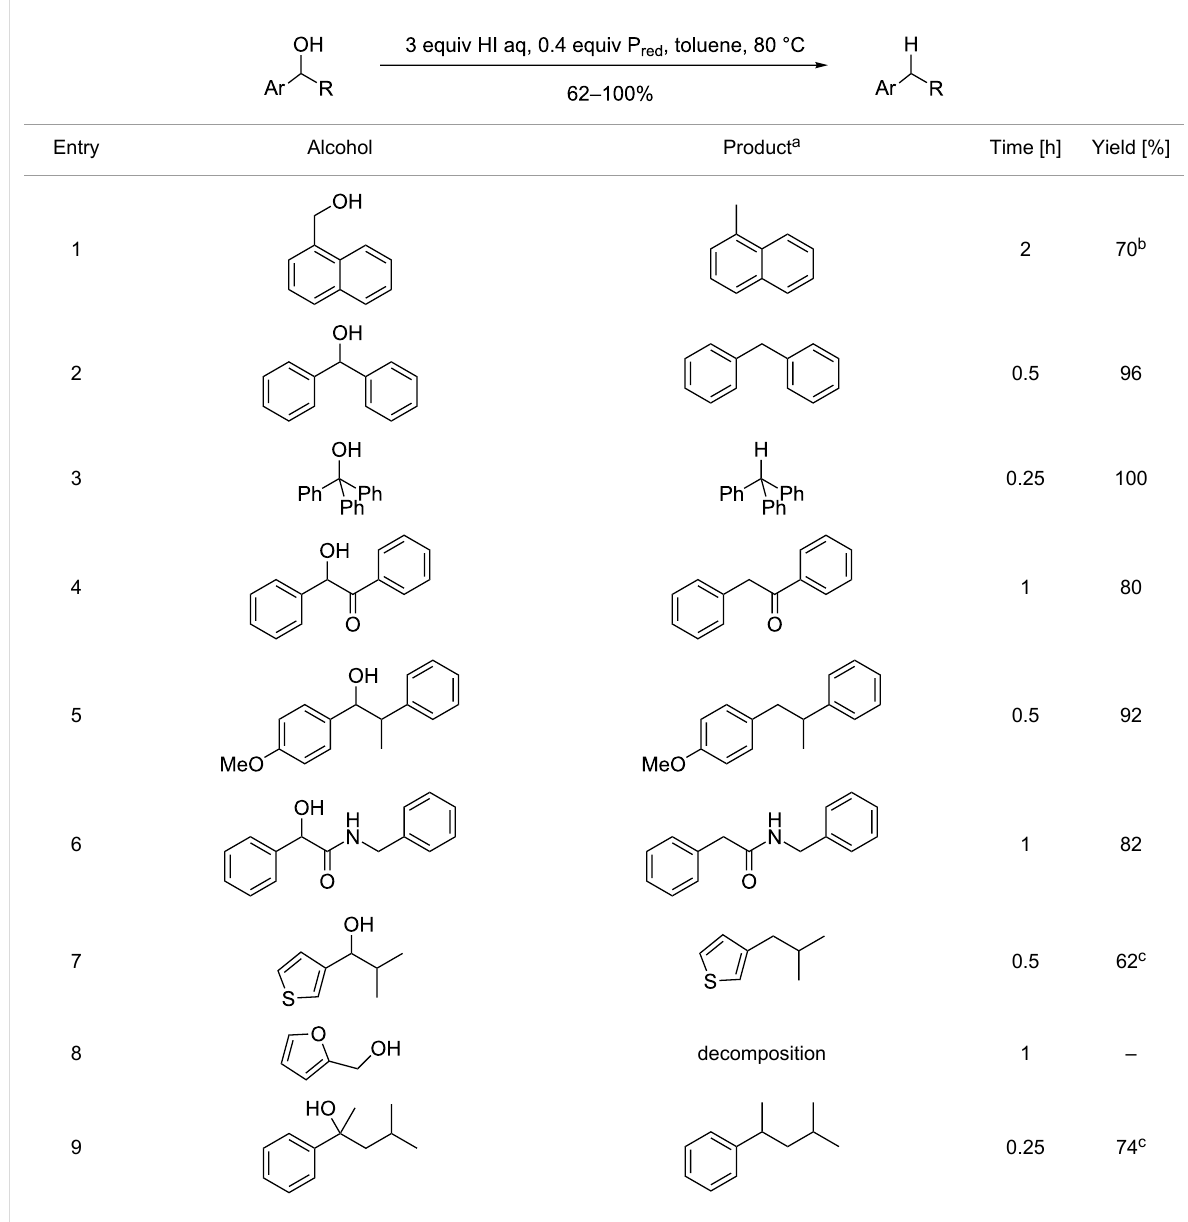
Table 1: Reduction of benzylic alcohols to the corresponding